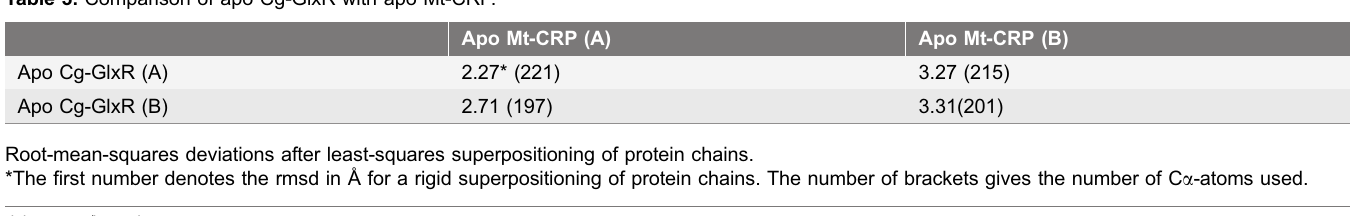
Table 3. Comparison of apo Cg-GlxR with apo